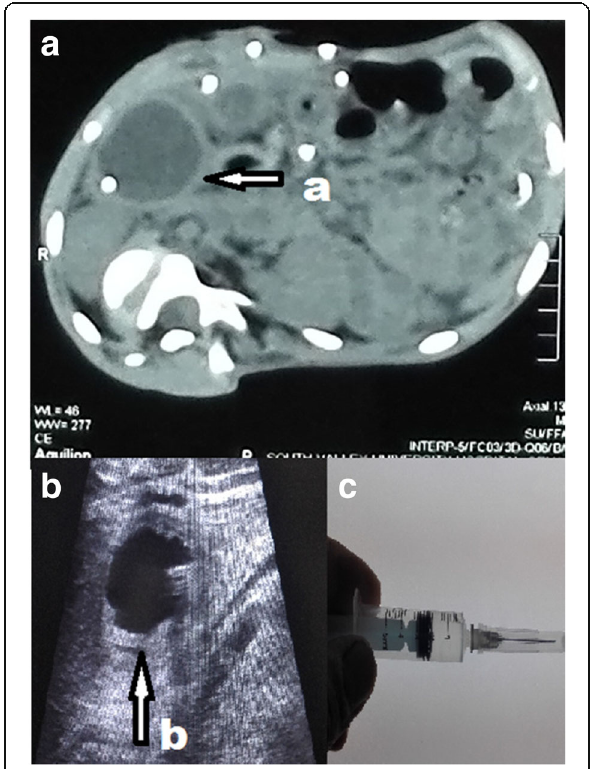
Fig. 10 a CT abdomen axial view of a 13-year-old male patient showing right hypochondrial cyst (a arrow). b Abdominal ultrasonography done for the same patient, and right hypochondrial cyst was found (b arrow).